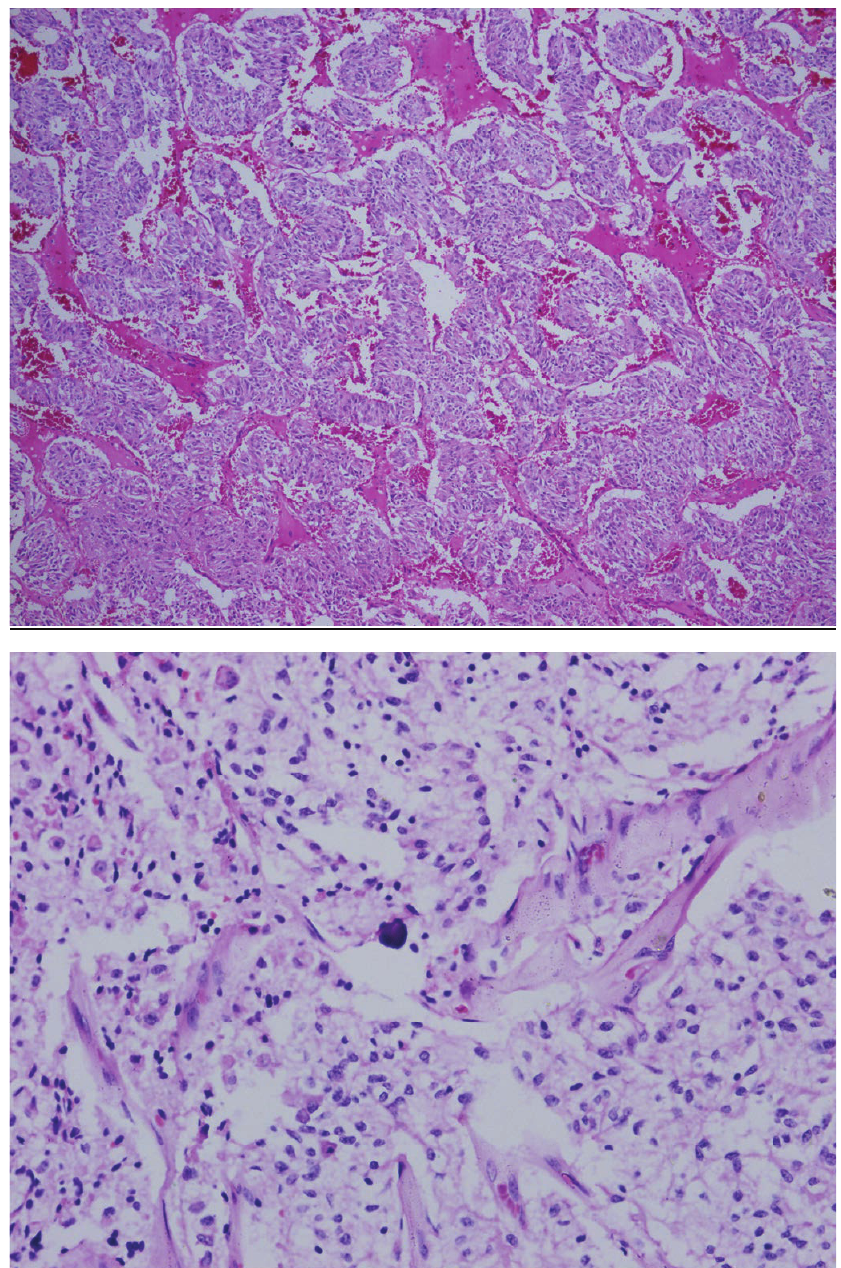
Figure 1: The upper microscopic slide (H&E) shows nests, trabeculae, and ribbons of columnar cells with clear to eosinophilic cytoplasm surrounded by a rich vascular network. The lower shows psammoma body in the center of the